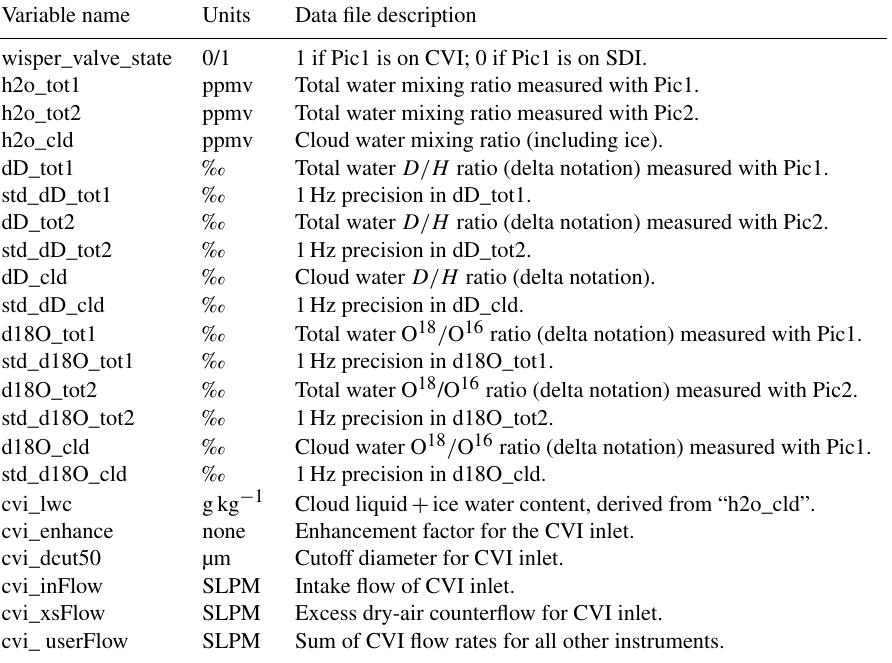
Table 3. WISPER variables and descriptions in the merged time series files. Note that in the data files, the first and second isotope analyzers are referred to as “Pic1” and “Pic2”, reflecting the Picarro brand used, whereas in this paper they are referred to as “WIA1” and “WIA2”. Descriptions of the analyzers can be found in Sect. 3. Variables ending in “_tot1” and “cld” are only available for the 2017 and 2018 sampling